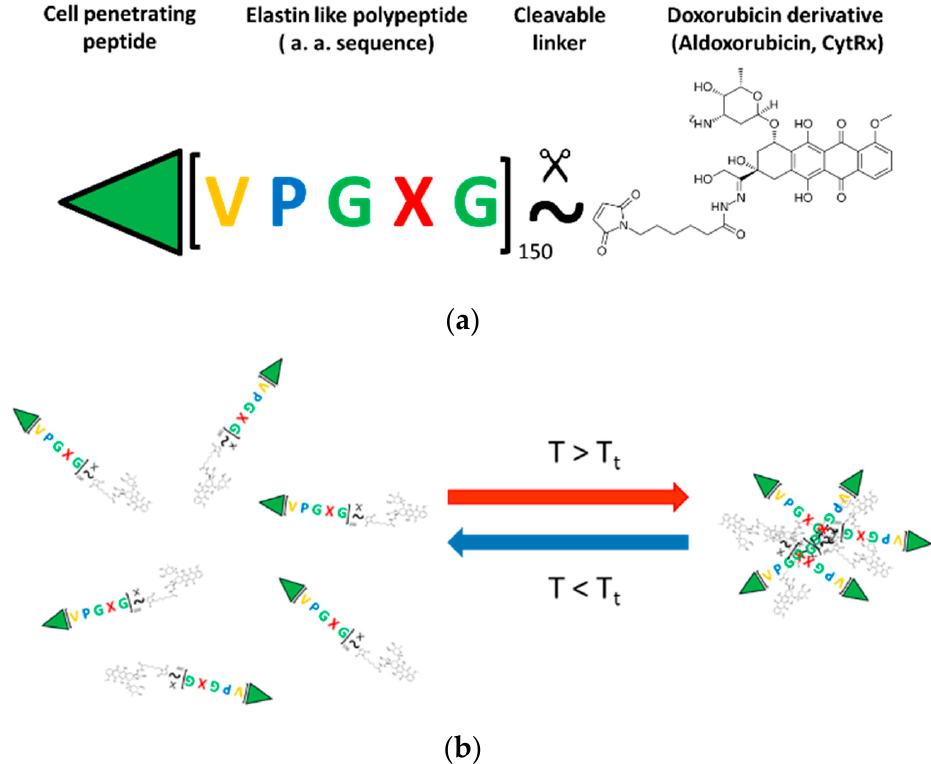
Figure 1. Schematics of the ELP-based drug delivery vector. ( a ) The developed drug vehicle is composed of a cell penetrating peptide (SynB1) to promote tumor and cellular uptake; thermally responsive elastin-like polypeptide (ELP); and the (6-maleimidocaproyl) hydrazone derivative of doxorubicin (DOXO-EMCH) containing a pH-sensitive hydrazine linker that releases doxorubicin derivative in the acidic tumor environment. ( b ) Below transition temperature ELP is present in the solution as a monomer. When temperature is increased above transition temperature ELP macromolecules form aggregates.